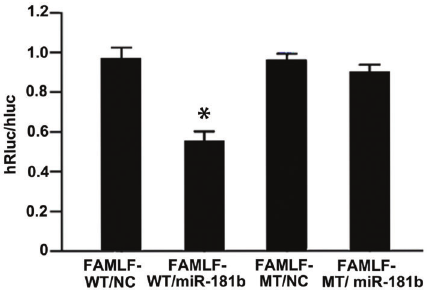
Figure 5. Dual-luciferase reporter gene assay. Renilla luciferase gene activity was reduced by half in 293T cells transfected with miR-181b mimics and the wild-type FAMLF 5 0 UTR sequence (FAMLF-WT/miR-181b), while miR-181b negative controls (FAMLF-MT/NC) and the mutated FAMLF 5 0 UTR sequence (FMALF-MT/miR-181b) caused no statistical changes in lucifer- ase gene expression. Data are reported as means ± SD (n=6). *P o 0.01, compared to FAMLF -WT/NC, FAMLF -MT/NC and